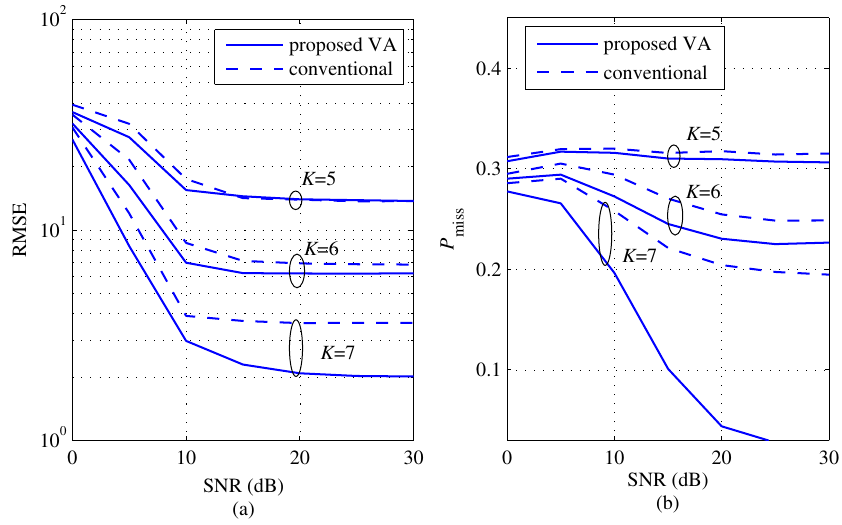
Figure 11. RMSE and probability of missing detection comparisons between the proposed and the conventional algorithms according to SNR for several K s with M = 3 ( θ 1 = − 21 ◦ , θ 2 = − 2 ◦ , θ 3 = 17 ◦ ), ( a ) RMSE; ( b ) probability of missing